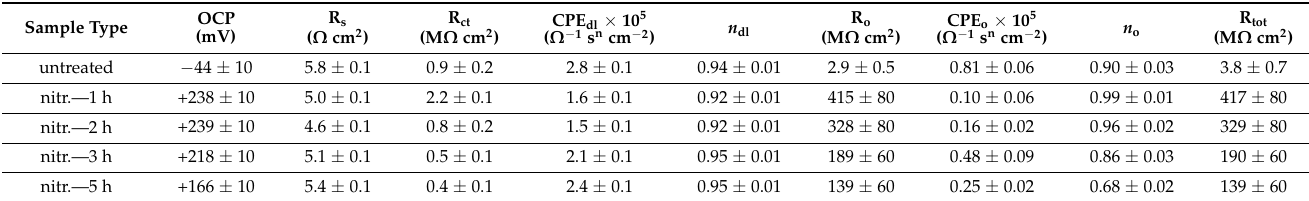
Figure 10. Bode plots of samples untreated, and nitrided at 360 ( a ) and 380 ( b ) ◦ C as indicated, recorded at the respective OCP values. Symbols: experimental data; lines: modelled data obtained using the equivalent electrical circuits depicted in insets A and B as explained in the text. Table 2. Best fitting EEC parameter values for EIS spectra of samples untreated and nitrided at 360 ◦ C for different durations, tested at the respective OCP (model: inset A in Figure 10a). EEC: equivalent electrical circuit. EIS: electrochemical impedance spectroscopy. OCP: open circuit potential. Rct: charge transfer resistance. CPEdl: double layer/space charge capacitance. CPE: constant phase elements.